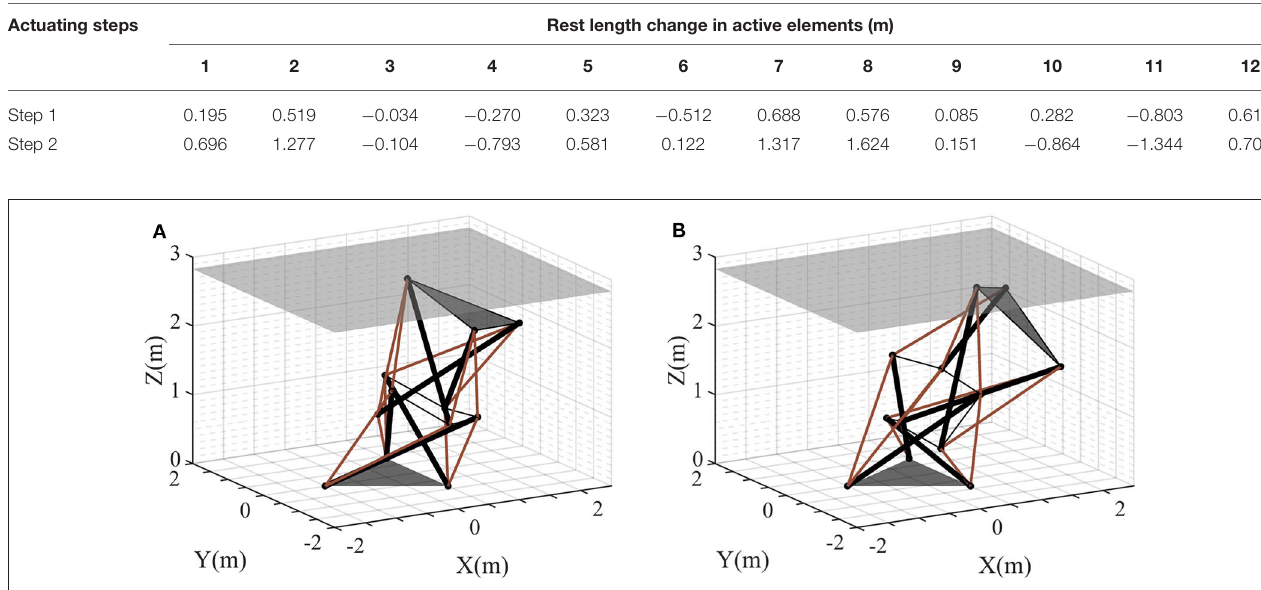
TABLE 3 | Optimal control strategy for the double-layered tri-prism tensegrity structure. Actuating steps